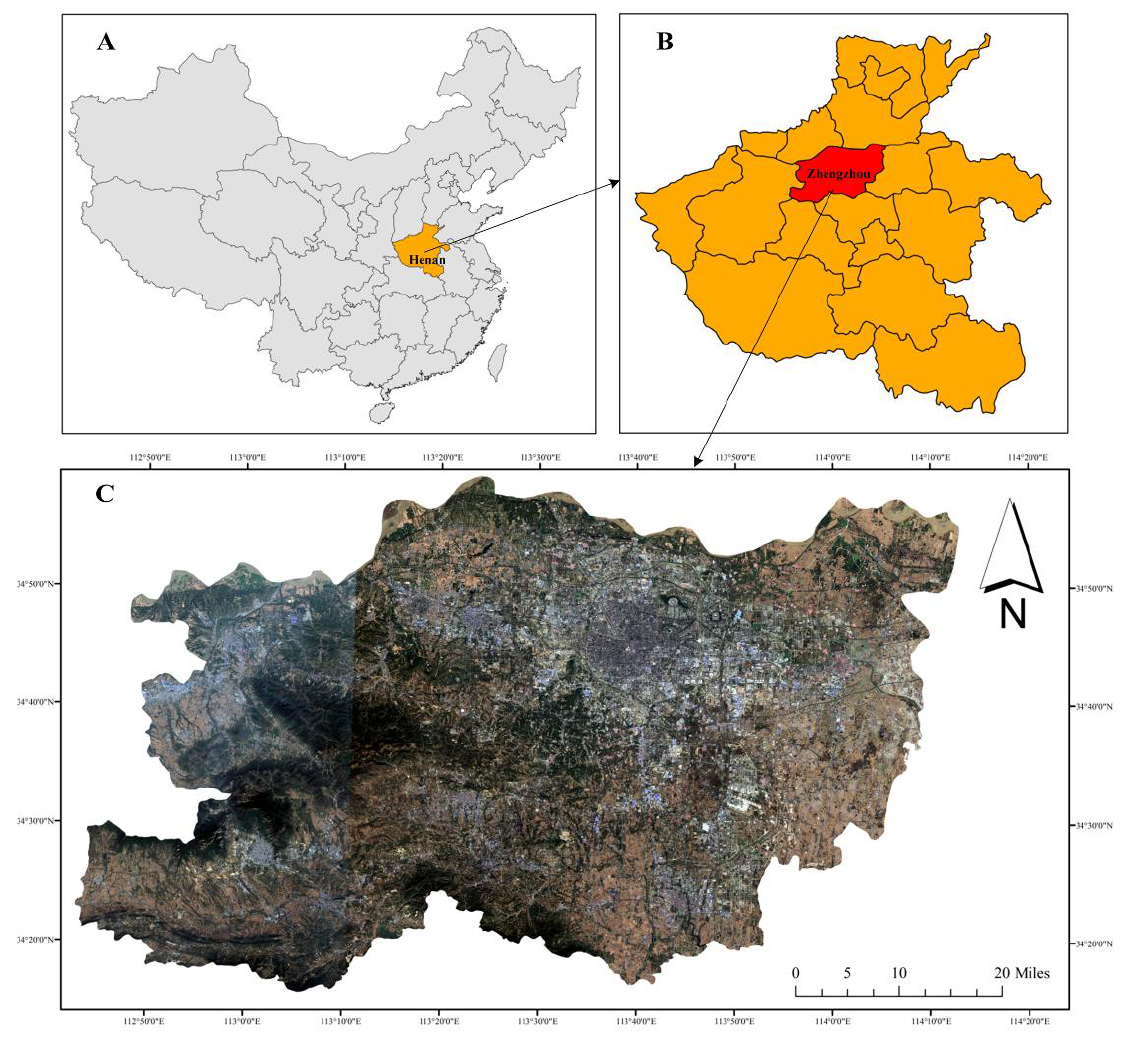
Figure 1. Location of the study area ( A ) and ( B ) Henan Province, China. ( C ) Sentinel-2 image of Zhengzhou, Henan Province.